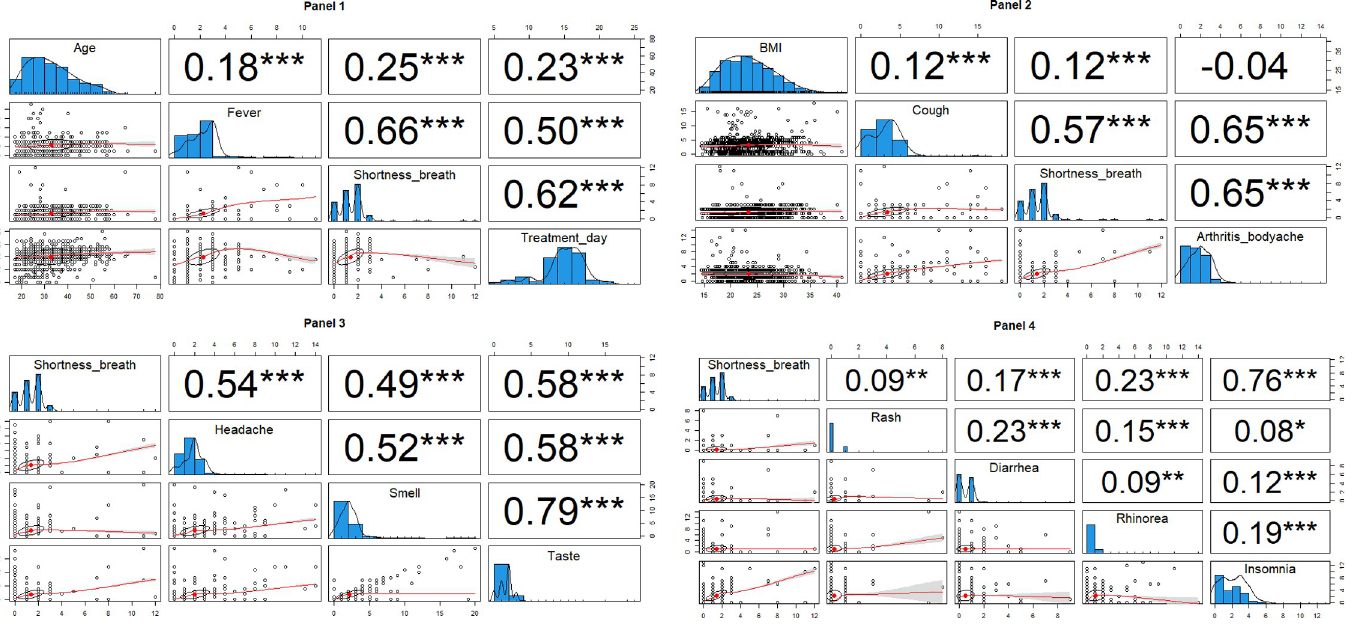
p = 0.001 on Supplement Table 5 in S1 Table ), and chronic arthritis (aOR 0.285, 95% CI